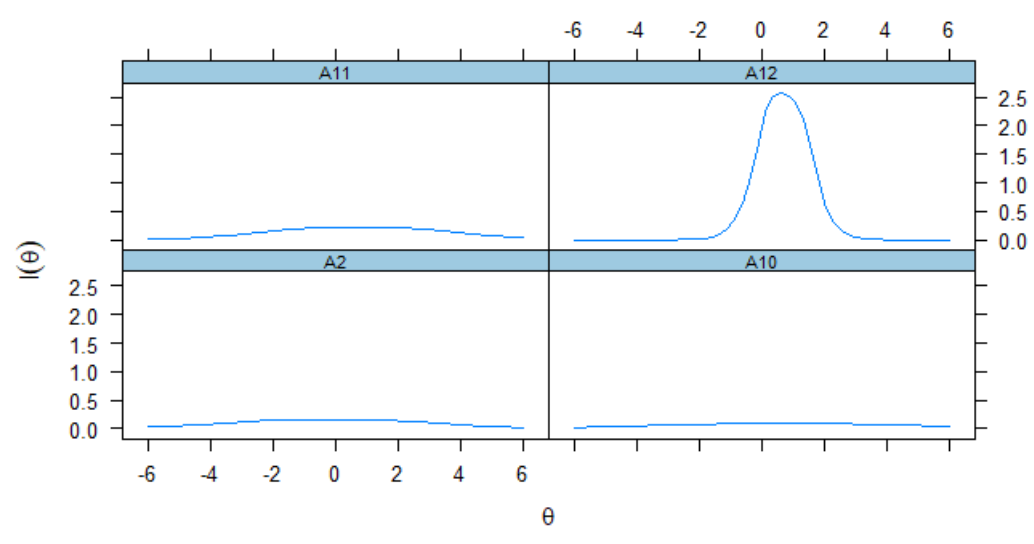
Figure 5. TICs of the Existential Needs component.